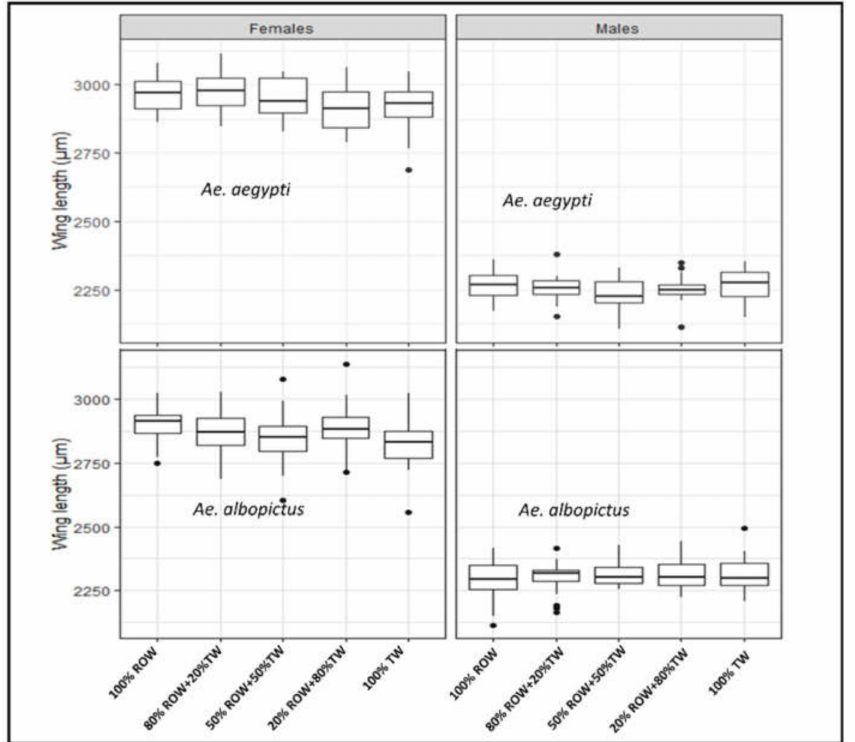
Figure 2. Body size of male and female Aedes aegypti and Aedes albopictus reared at different hard- ness/electrical conductivity levels of larval rearing water. Each box denotes the median as a line across the middle, the quartiles (25th and 75th percentiles), the minimum and maximum values at the ends of the vertical lines. Results are expressed as mean ± SE. ROW = reverse osmosis water, TW = tap